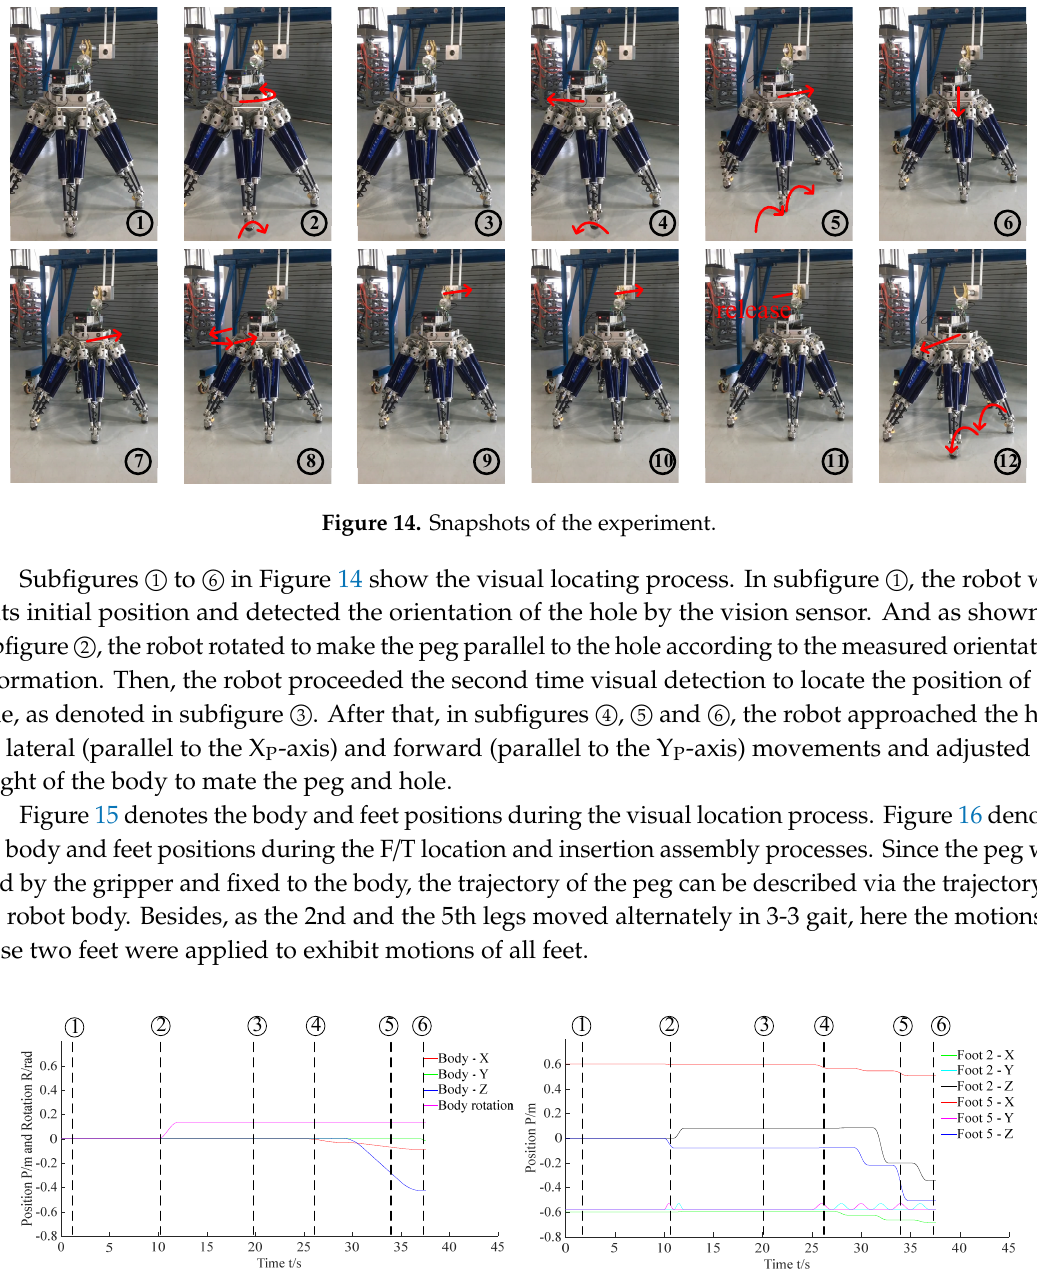
Figure 15. Motions of the body and feet in the process of visual locating.